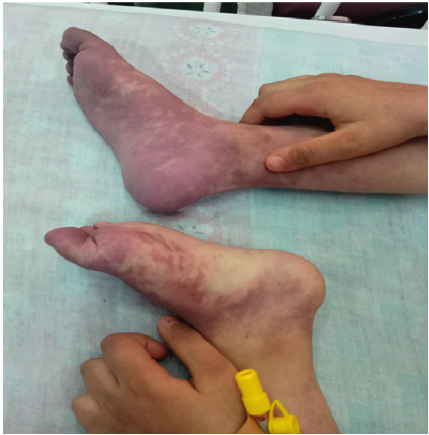
Figure 1: Bilateral bluish feet at admission. Table 1: Routine laboratory